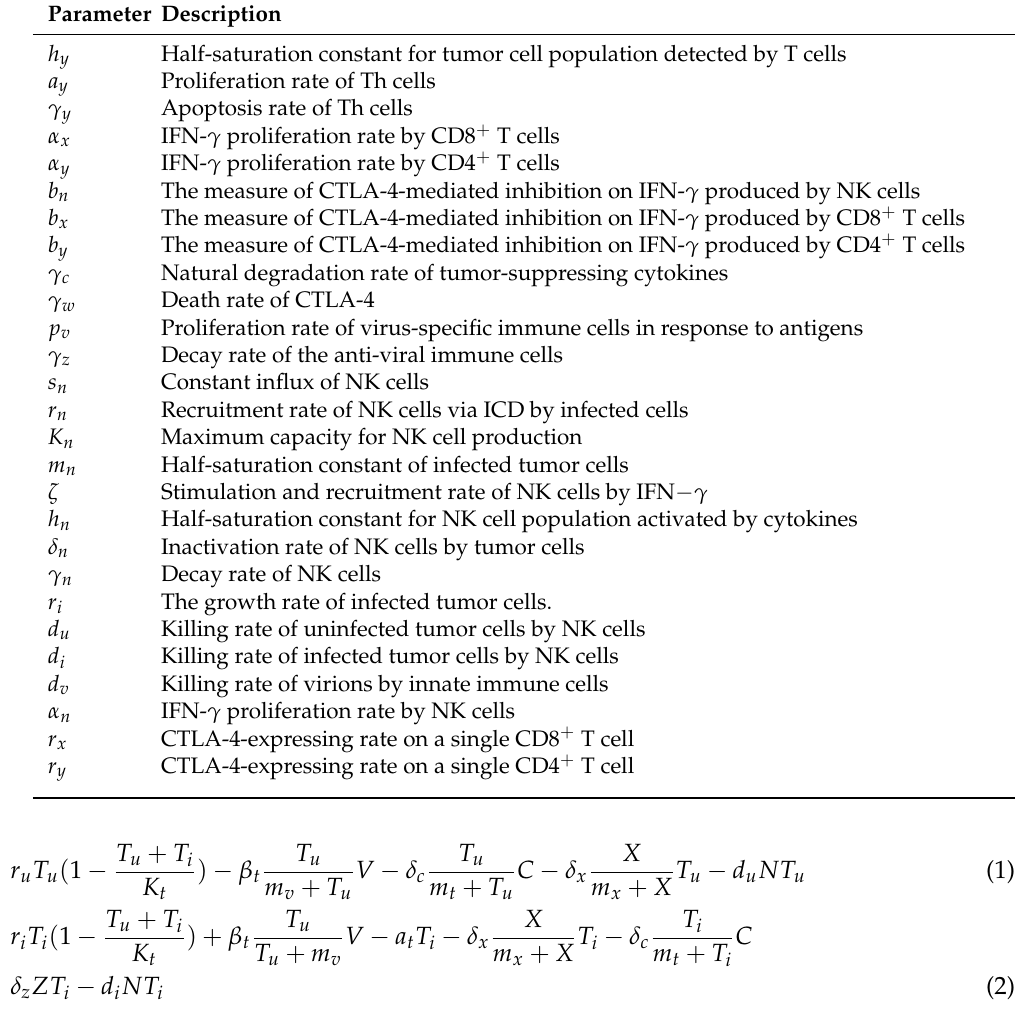
Table 2. Cont. Parameter